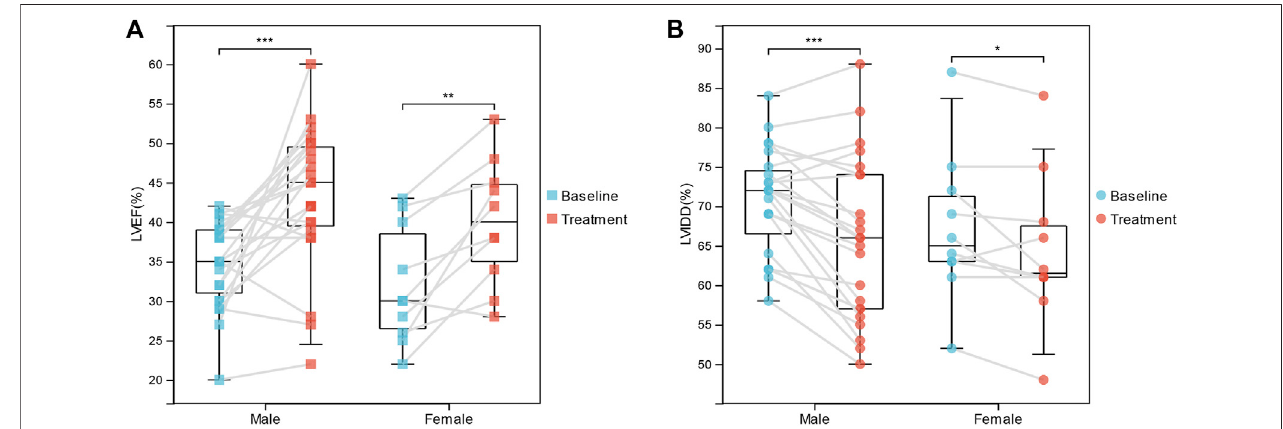
FIGURE 1 | Correlations Between IgG immunotherapy and Clinical Outcome Features. (A) LVEF in paired baseline and IgG treatment DCM patients. (B) LVIDD in paired baseline and IgG treatment DCM patients. *, p < 0.05; **, p < 0.01; and ***, p <